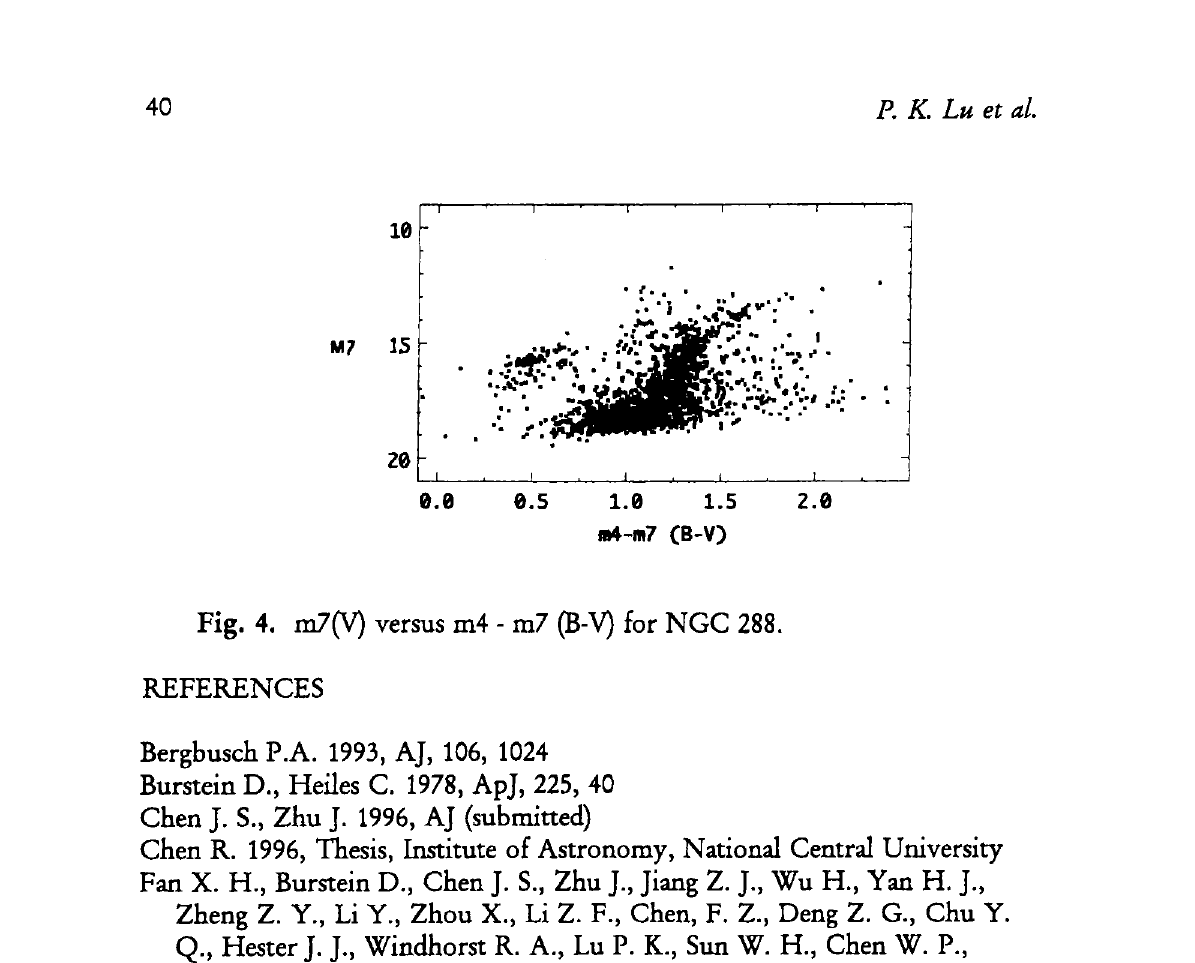
Fig. 4. m7(V) versus m4 - m7 (B-V) for NGC